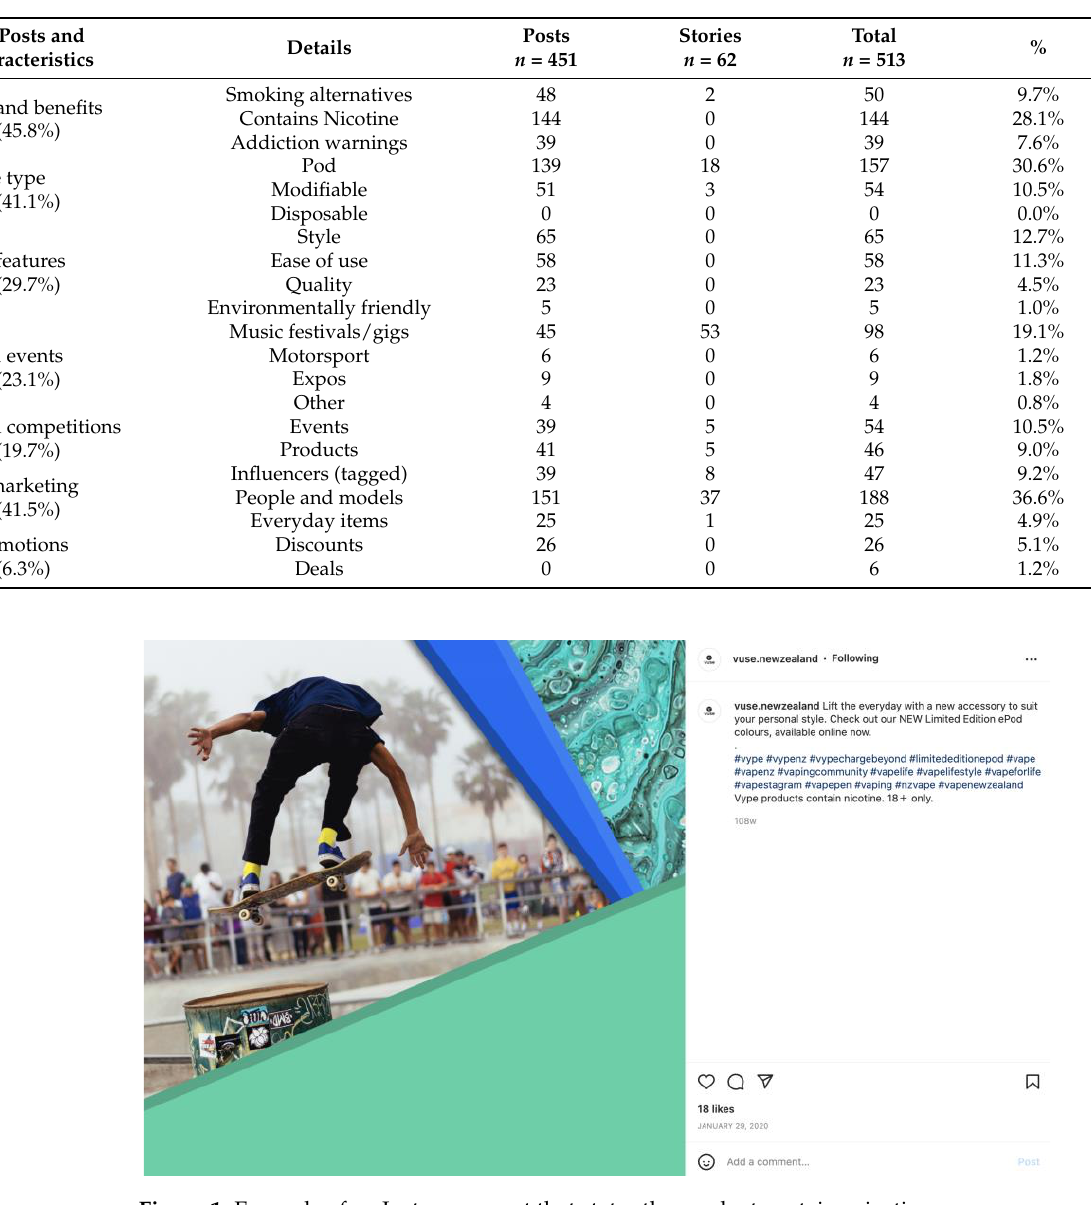
Figure 1. Example of an Instagram post that states the product contains